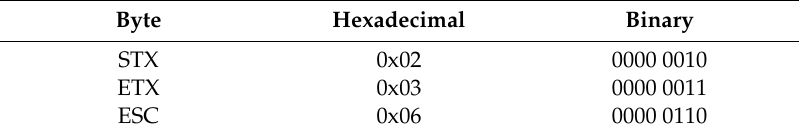
Table 3. Codification of special characters including their hexadecimal and binary